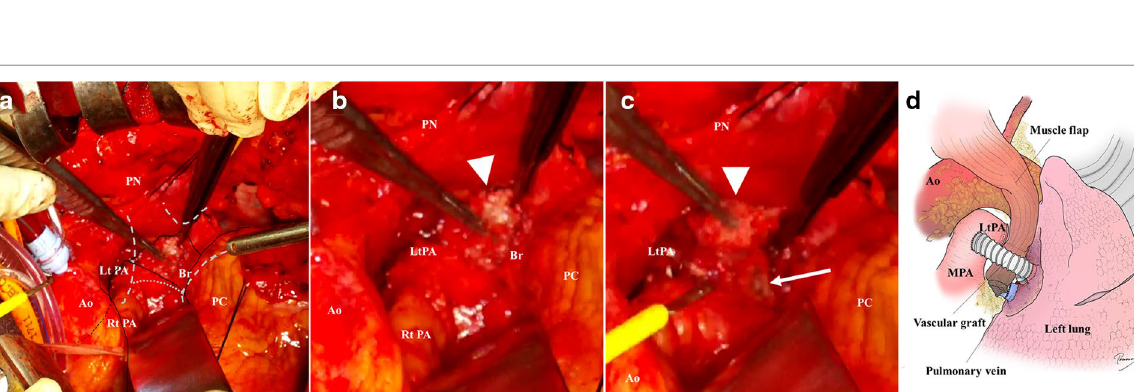
membrane oxygenation from right femoral vein to right femoral artery before finishing the operation.